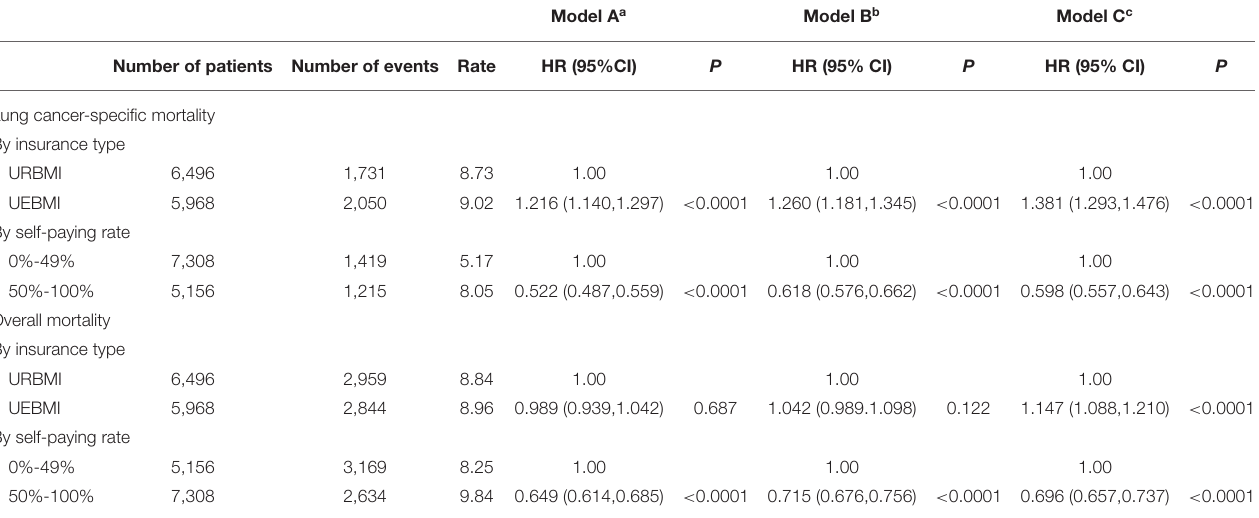
TABLE 3 | Associations of insurance type and self-paying rate with lung cancer-specific death and all-cause death. Model A a Model B b Model C c Number of patients Number of events Rate HR (95%CI) P HR (95% CI) P HR (95% CI)